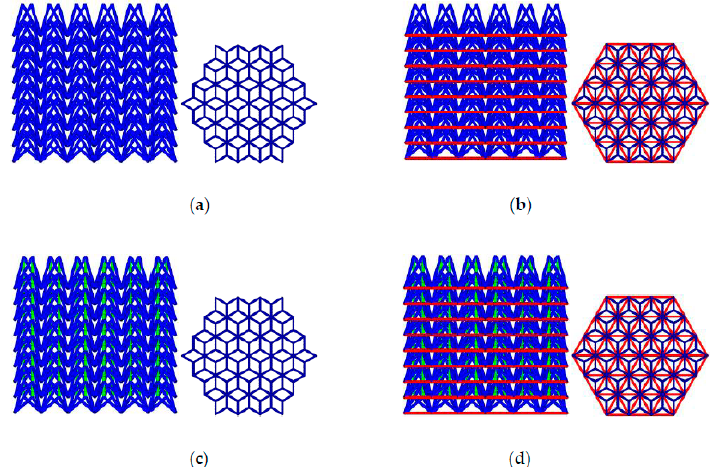
Figure 18. Structures fabricated by four novel NPR cells: ( a ) Type A NPR structure; ( b ) Type B NPR structure; ( c ) Type C NPR structure; ( d ) T ype D NPR structure.